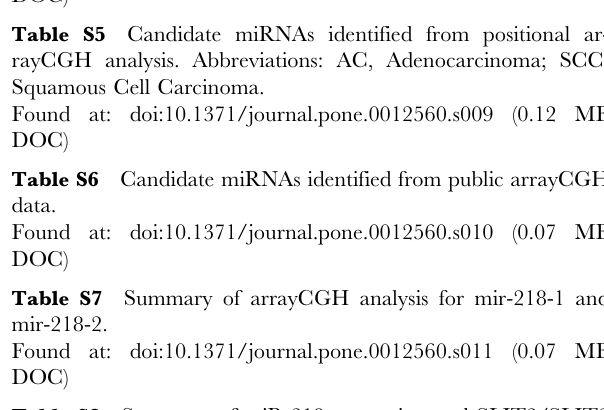
Table S8 Summary of miR-218 expression and SLIT2/SLIT3 expression and copy number changes. Abbreviations: FC, Fold